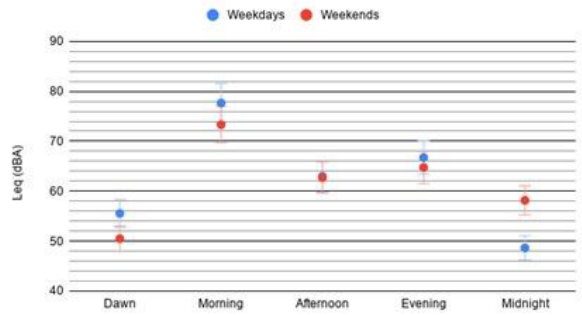
Figure A1: Comparison of the day history of the noise levels (L Aeq , T = 1 min) on weekdays (blue) and weekends (red) in July–August (19 July to 2 August 2020). The plot of each time block is the averaged value over all weekdays and weekends during the observation period. Error bars are also indicated (95% range). Note that the significant difference was not observed by t-test between Weekdays and Weekends: t (57) = 0.18, p = 0.86.